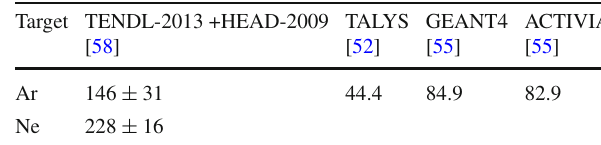
Table 4 Production rates (in kg − 1 day − 1 ) of 3 H at sea level calculated for Ar and Ne from TENDL-2013 and HEAD-2009 libraries as in [58]; other available values taken from the literature are shown for